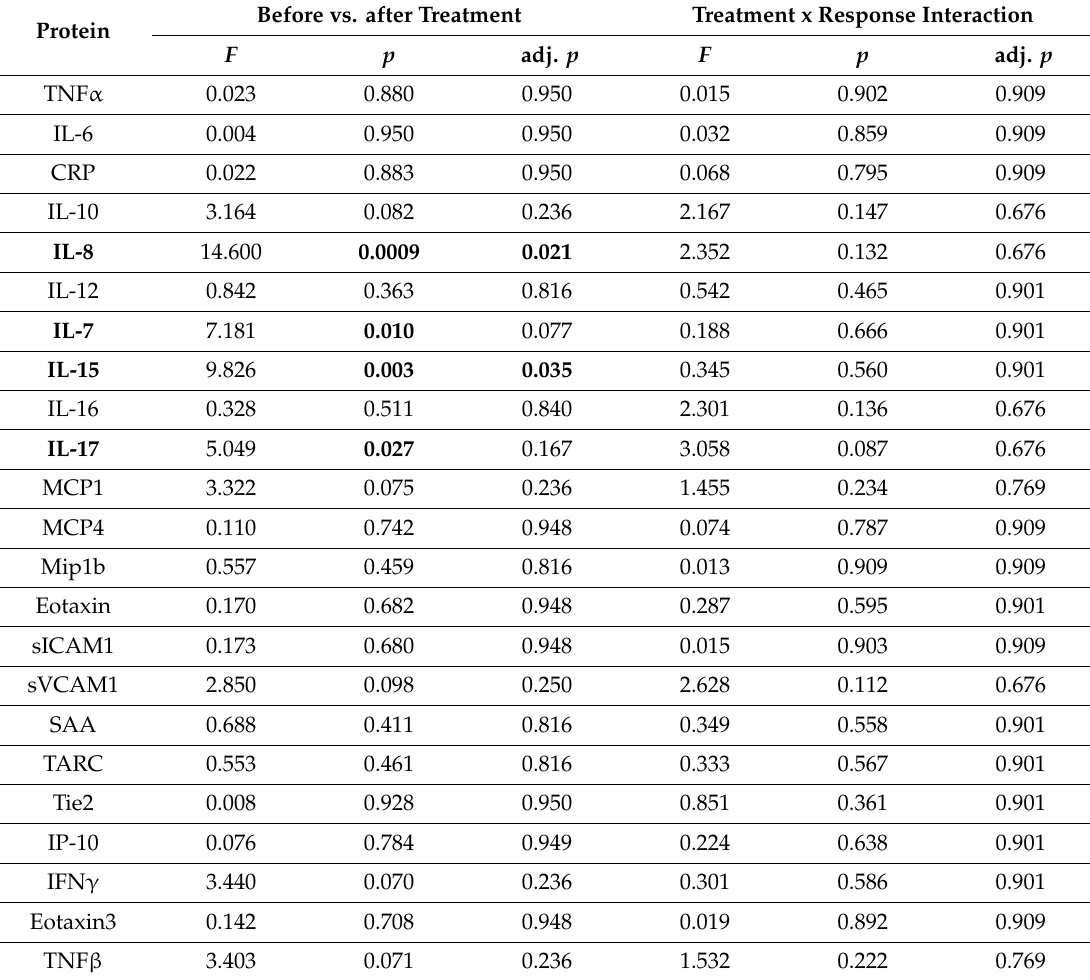
Table 3. Inflammatory changes over treatment period in responders and non-responders.